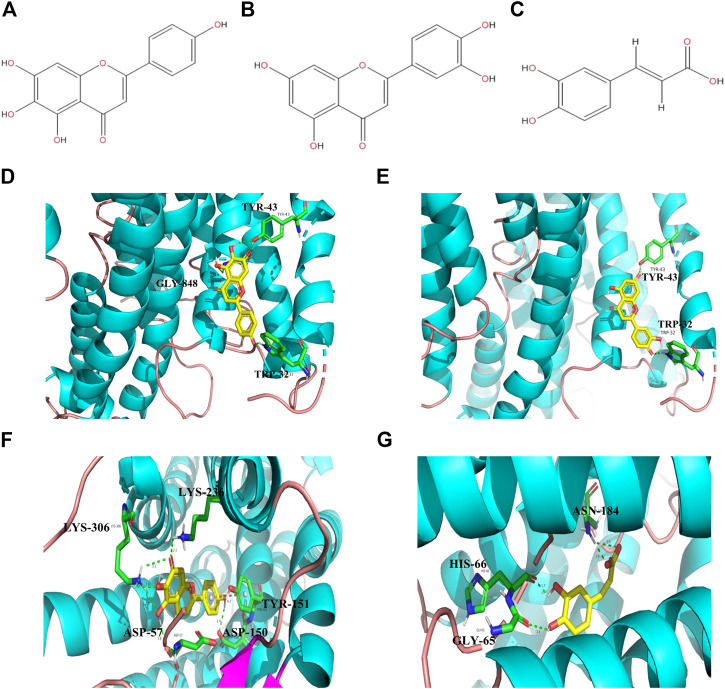
Computer simulation of molecular docking. (A) The structure of scutellarein. (B) The structure of luteolin. (C) The structure of caffeic acid. (D) Scutellarein combines with Na+/K+-ATPase. (E) Luteolin combines with Na+/K+-ATPase. (F) Scutellarein combines with opioid receptor. (G) Caffeic acid combines with AQP4.